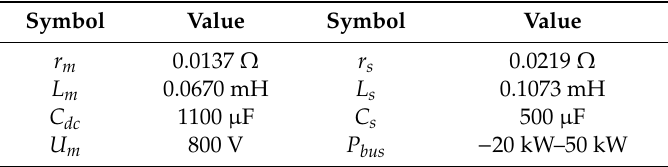
Table 1. Parameters of the multi-terminal AC / DC